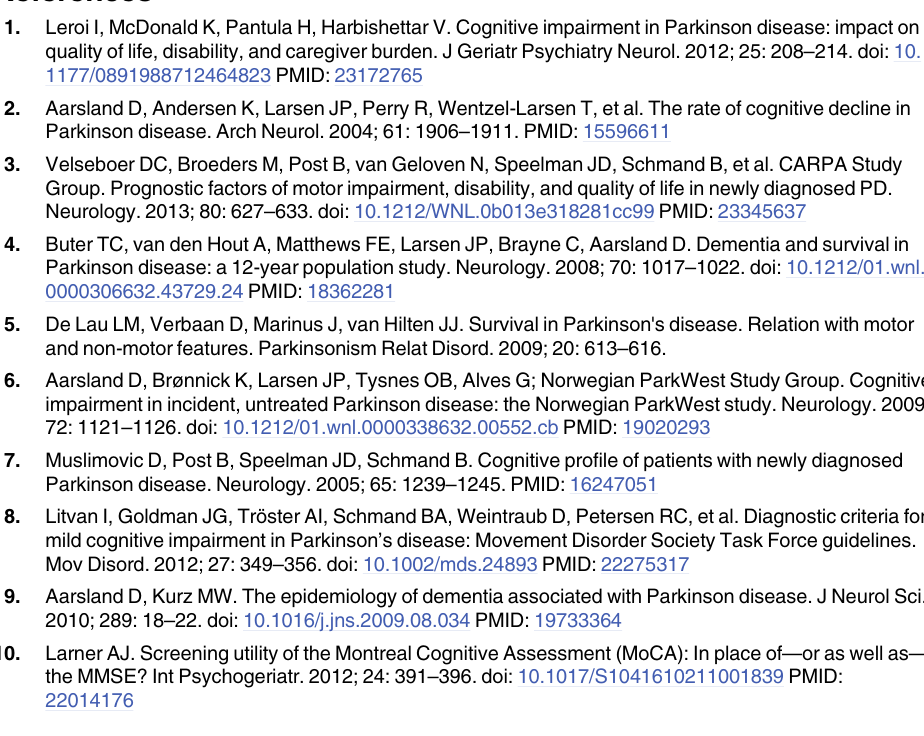
(PDF) S2 Table. Z-Scores of neuropsychological test battery for all cognitive groups in study 2.